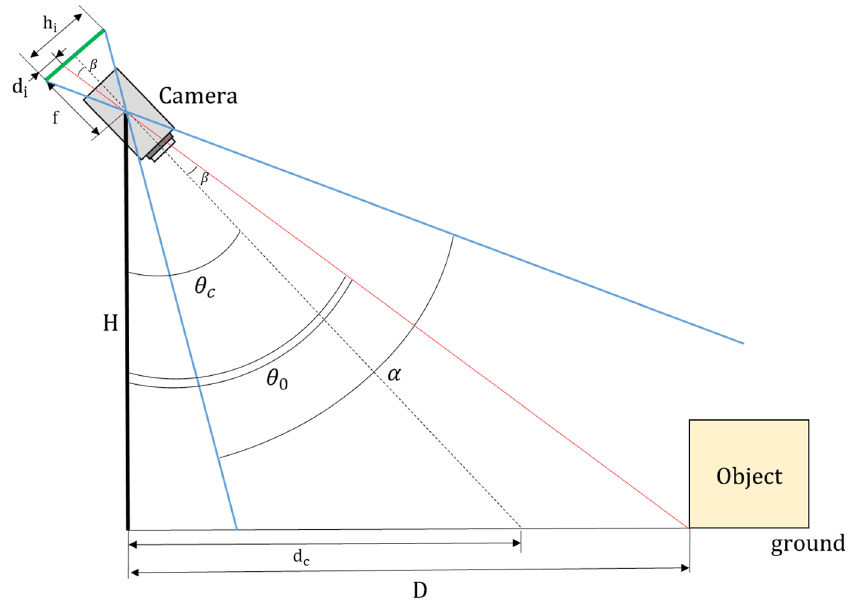
Figure 5. Distance estimation between object and camera.